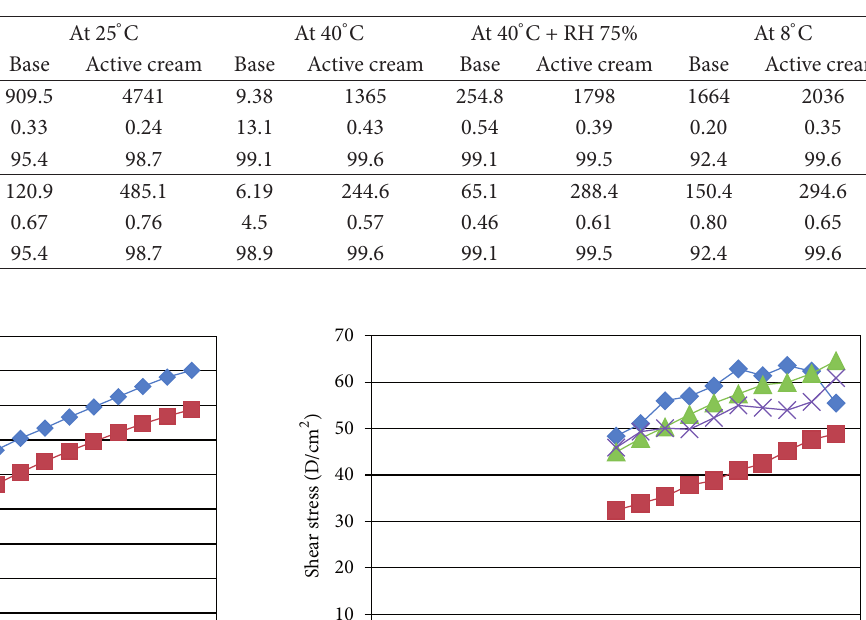
T 3: Rheological parameters at four weeks of base and active cream kept at 25